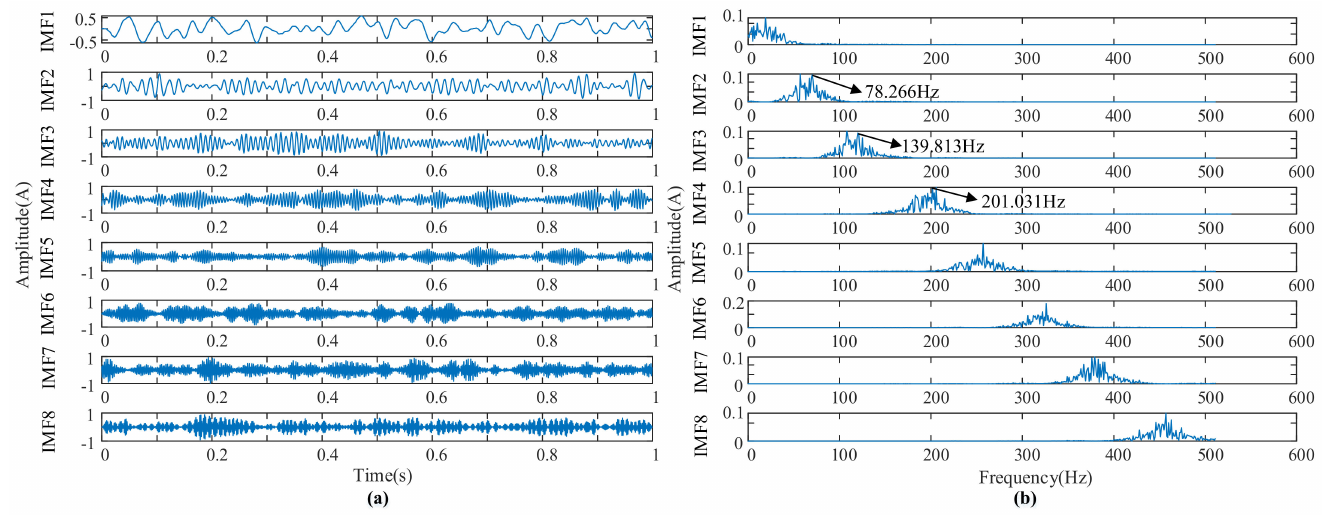
Figure 21. VMD decomposition of time − frequency domain signal of compound